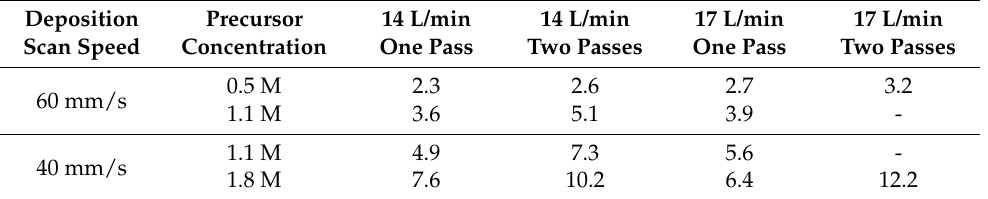
Table 2. Atomic percentage of Zn for the coatings obtained at different deposition parameters.